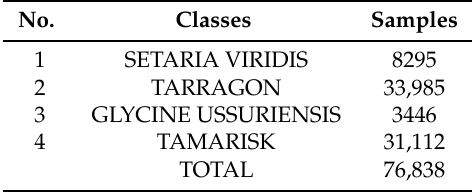
Table 4. Labeled samples in Glycine Ussuriensis Dataset.